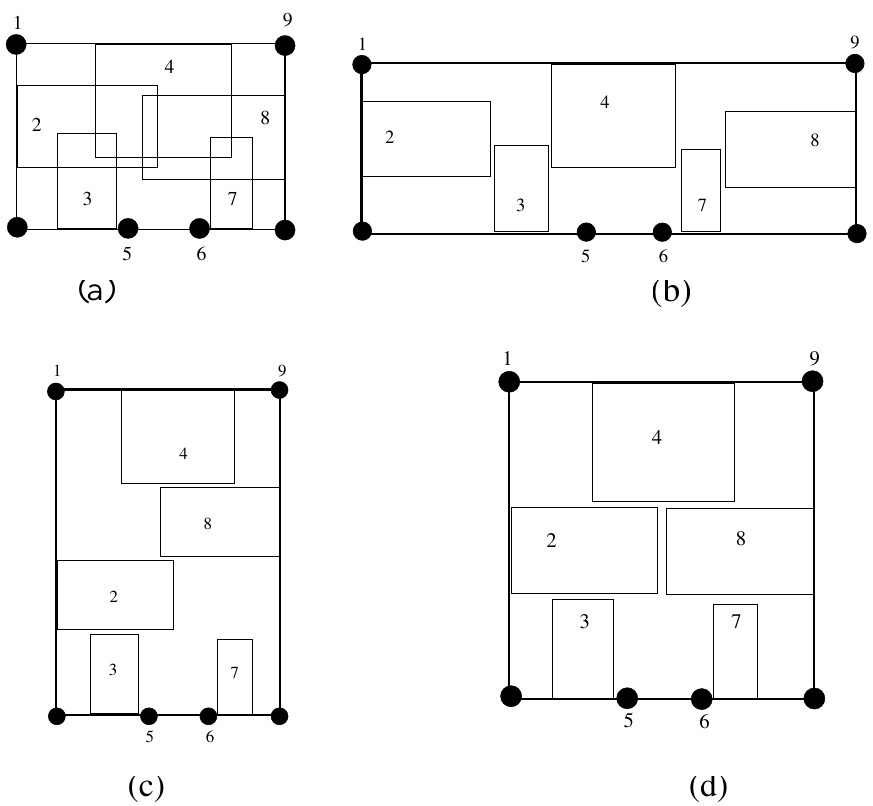
Figure 24. ( a ) A sample orthogonal drawing where we resolve label overlaps by increasing: ( b ) only the width; ( c ) only the height; and ( d ) the width and